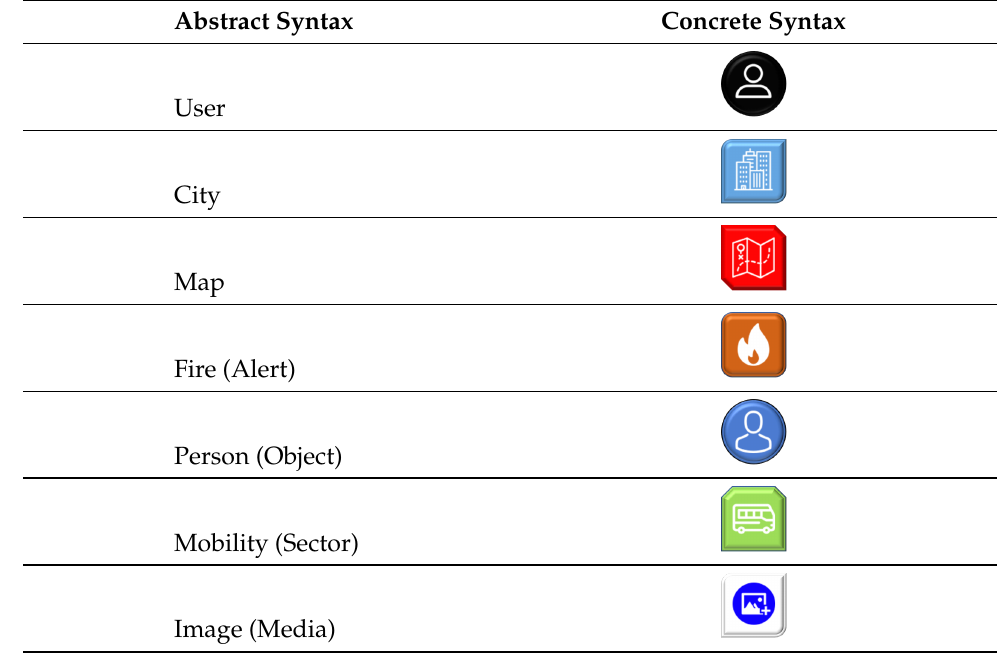
Table 1. CrowDSL abstract and concrete